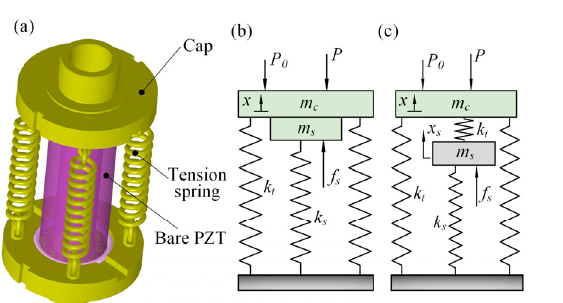
Figure 5. AnalysisofPZTstack. ( a )Structurallayout; ( b )idealequivalentmodel; ( c Figure 5. Analysis of PZT stack. ( a ) Structural layout; ( b ) ideal equivalent model; ( c ) new equivalent model.